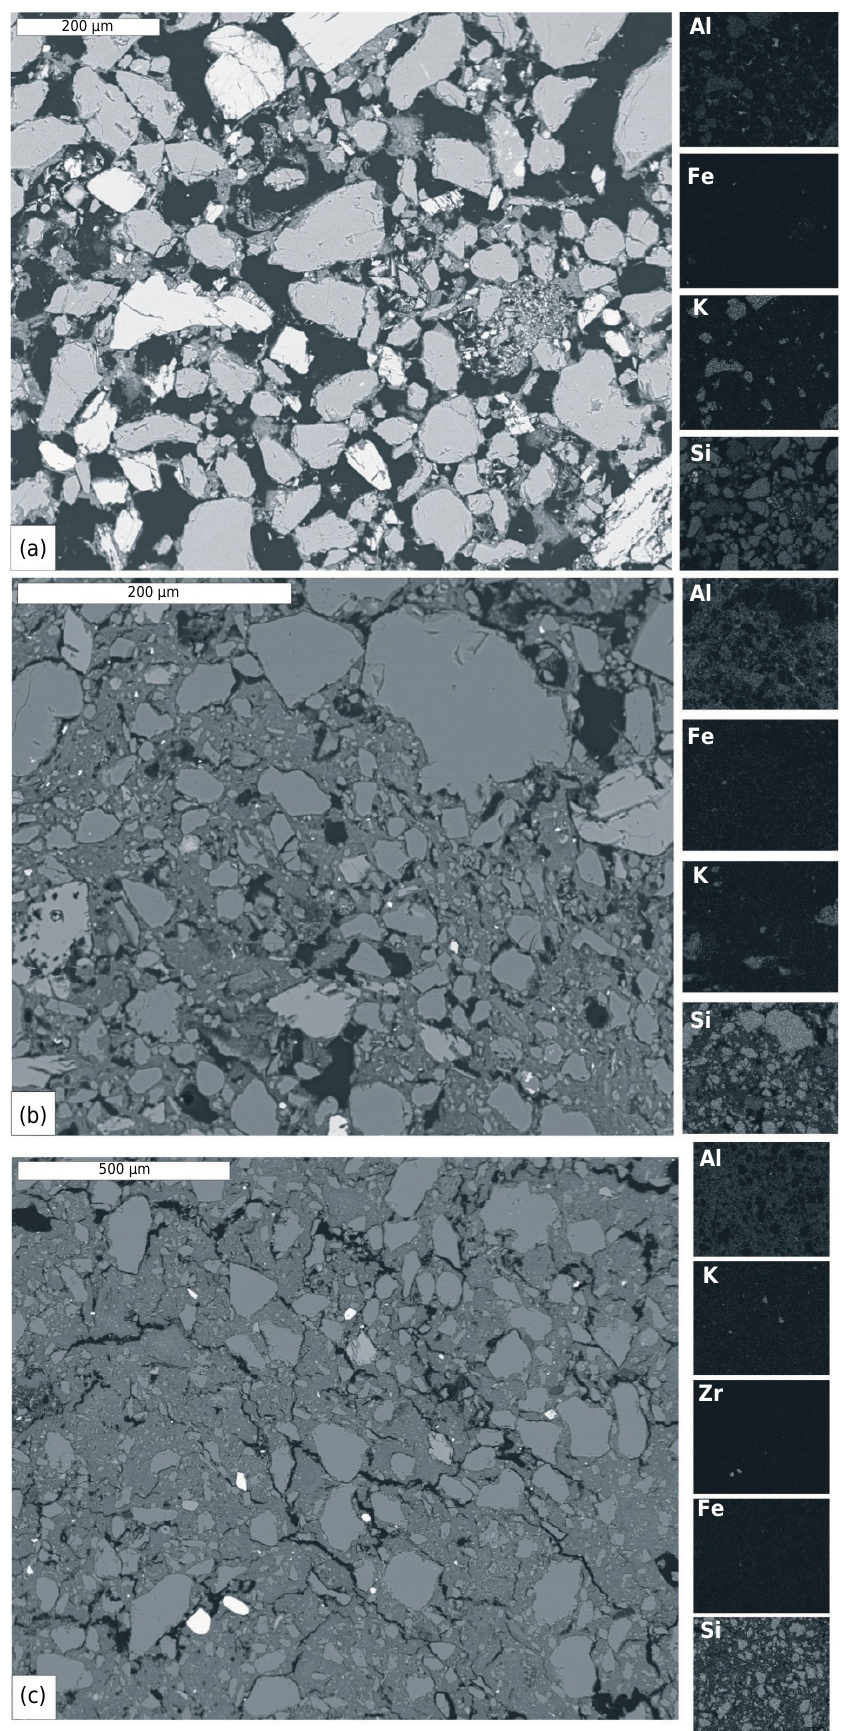
Figure 5. Backscattered electrons images and microchemical maps of soil horizons: (a) C1 of P5 with high porosity and (b) 2C4 horizon of P5 with higher clay content; and (c) Bt1 horizon of P6 with high clay